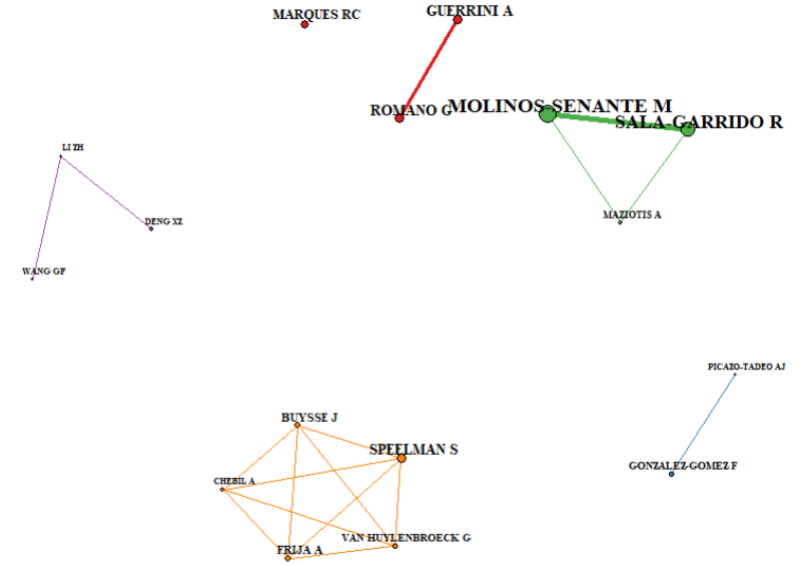
Figure 2. Author collaboration network.